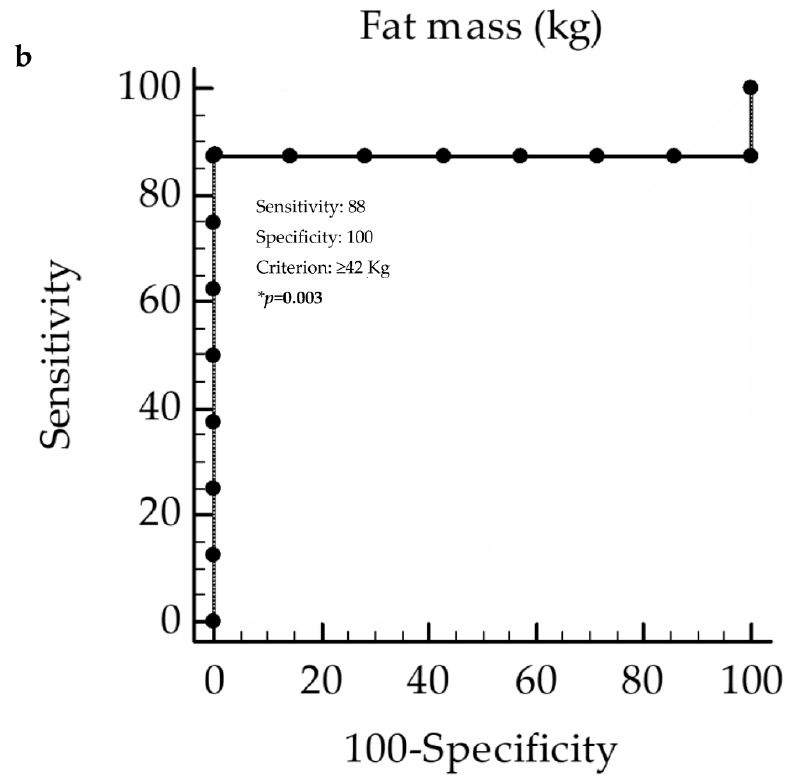
Figure 5. ROC for predictive values of BMI ( a ) and fat mass ( b ) in detecting the lowest decrease in 25OHD levels. * A p value in bold type denotes a significant di ff erence ( p < 0.05). ROC, Receiver Operator Characteristic; BMI, Body Mass